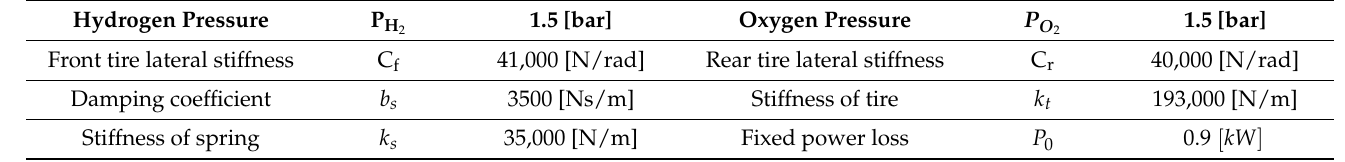
Table A1. The values of the vehicle